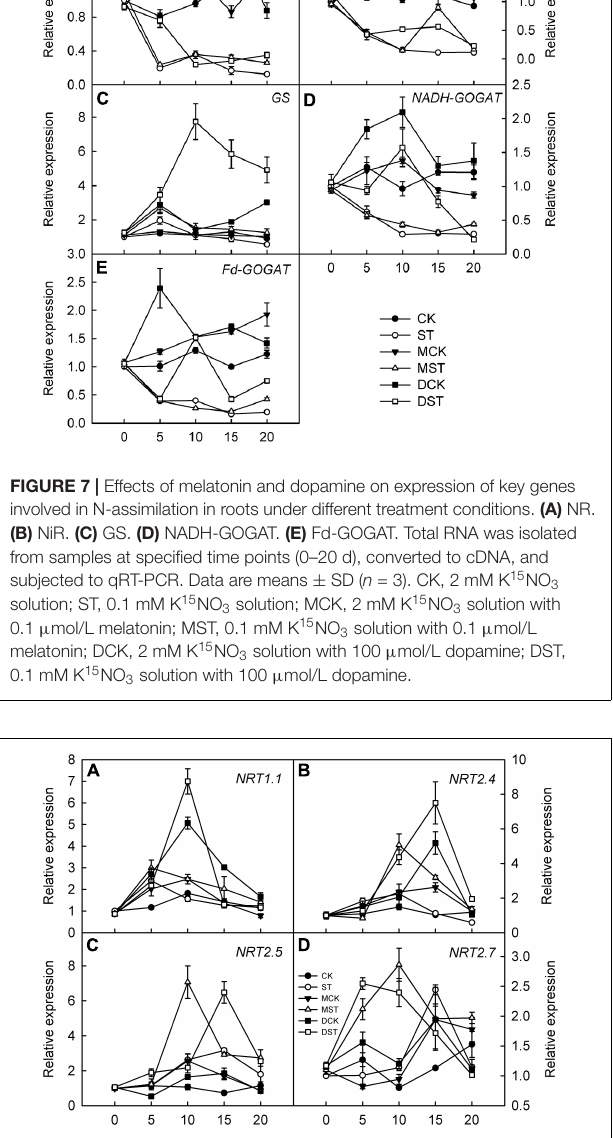
FIGURE 8 | Effects of melatonin and dopamine on expression of key genes involved in N-uptake in leaves under different treatment conditions. (A) NRT1.1. (B) NRT2.4. (C) NRT2.5. (D) NRT2.7. Total RNA was isolated from samples at specified time points (0–20 days), converted to cDNA, and subjected to qRT-PCR. Data are means ± SD ( n = 3). CK, 2 mM K 15 NO 3 solution; ST, 0.1 mM K 15 NO 3 solution; MCK, 2 mM K 15 NO 3 solution with 0.1 µ mol/L melatonin; MST, 0.1 mM K 15 NO 3 solution with 0.1 µ mol/L melatonin; DCK, 2 mM K 15 NO 3 solution with 100 µ mol/L dopamine; DST, 0.1 mM K 15 NO 3 solution with 100 µ mol/L dopamine.